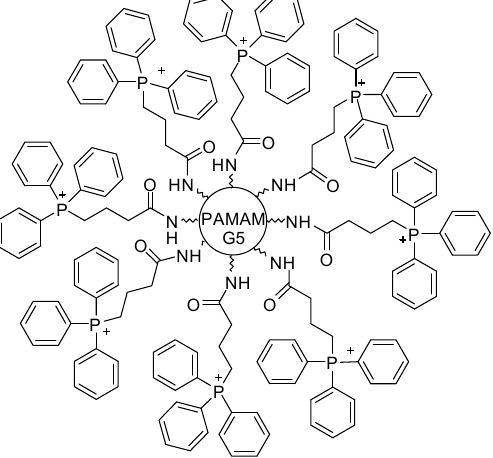
Figure 12. Dendrimer E9-2 with a high ability of gene transfection in a stem cell model [102].